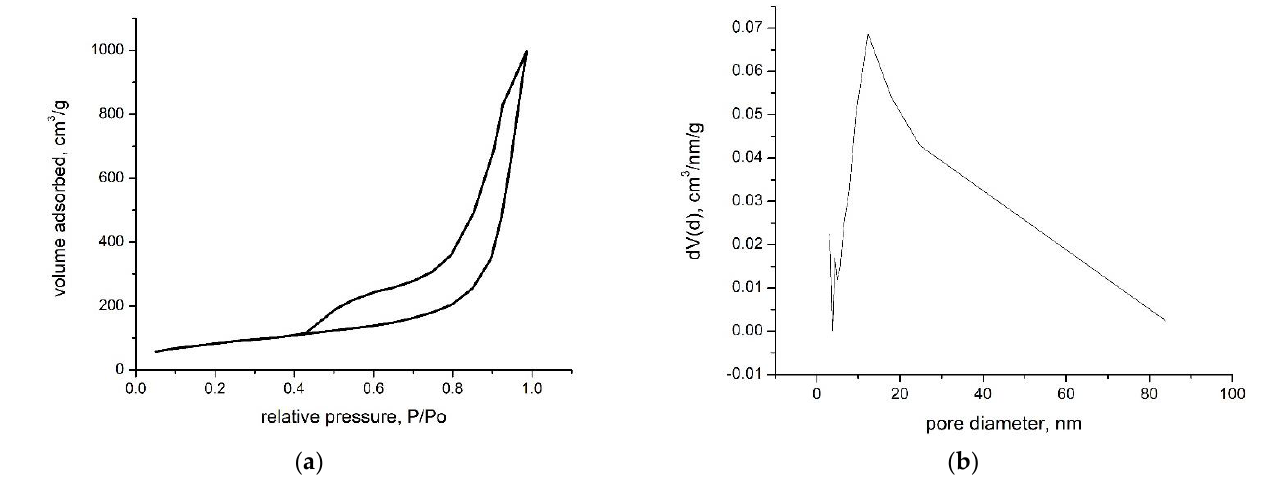
Figure 3. N 2 adsorption-desorption isotherm for composite material ( a ) and pore size distribution ( b